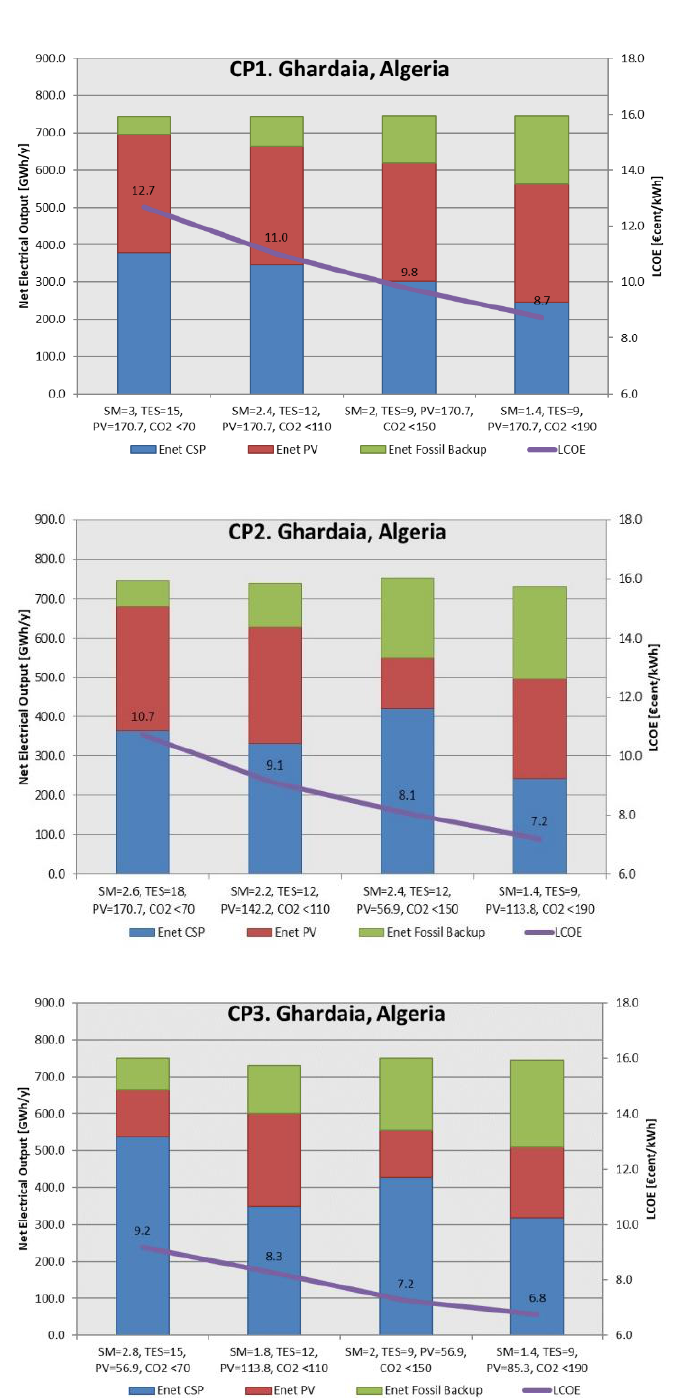
Figure 7. Energy production per configuration case (CP) and location. Solar multiple (SM), thermal storage capacity in full load hours (TES), nominal PV capacity in MW and CO 2 emissions in g CO 2 / kWhe.